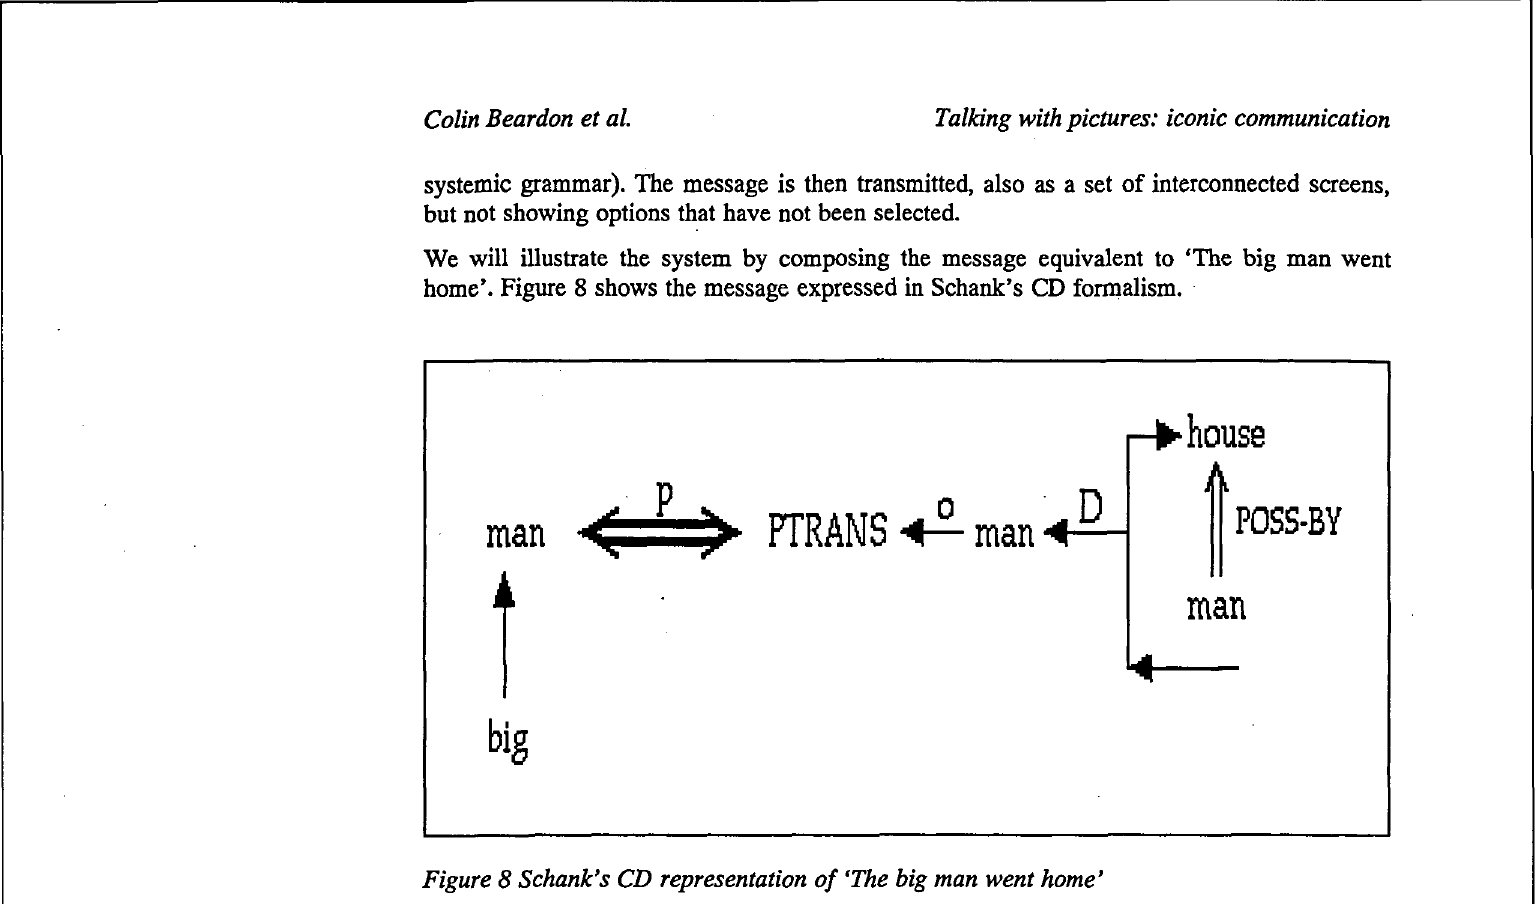
Figure 8 Schank's CD representation of 'The big man went